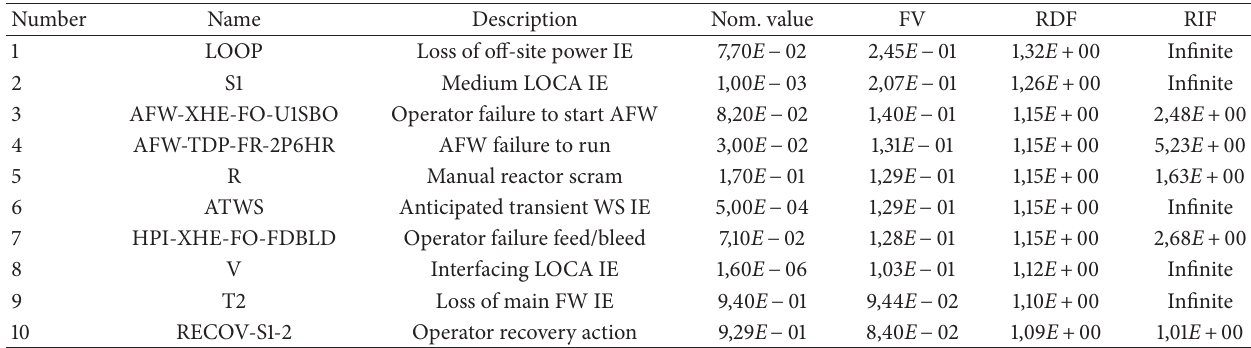
Table 9: The basic events with the largest FV importance measure in reference model.